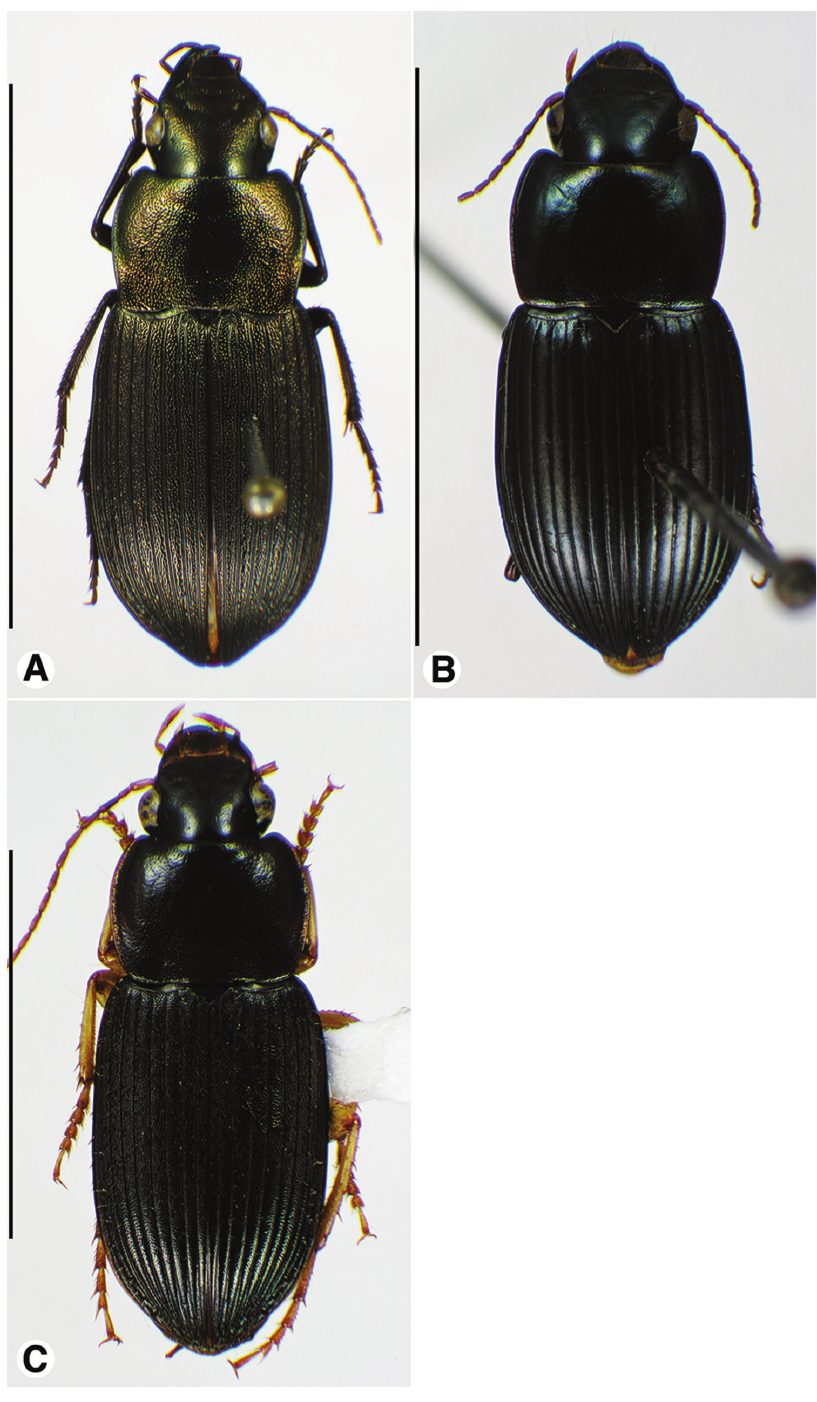
Figure 1. Habitus digital images, dorsal aspect. A Neoaulacoryssus cupripennis (Gory) B Paraulacoryssus puertoricensis (Mutchler) C Athrostictus paganus (Dejean). Scale bars: A 15 mm; B 10 mm; C 5